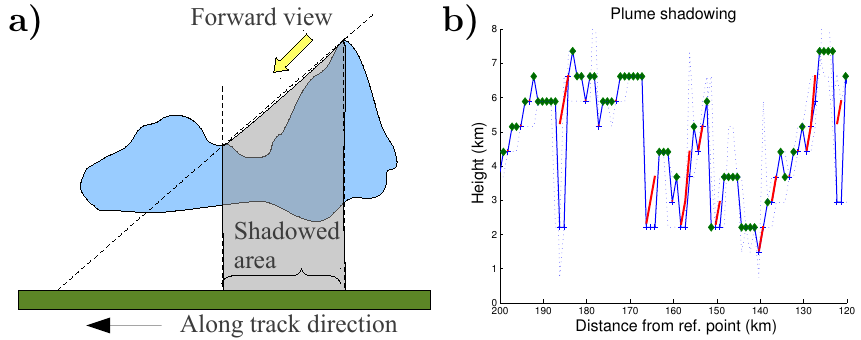
Figure 9. (a) Principle of the plume shadowing. A high feature can block the forward view (for lower features) in the along-track direction. A reliable height estimate cannot be obtained for pixels in the shadowed area. (b) An example of shadow masking, an along-track height profile. The blue line shows the initial height estimate. The high features block the forward view on the areas indicated by the red lines, preventing the height estimate. The green dots indicate heights accepted after the shadow masking. Note that in the shadowed areas the method typically suggests uniform, underestimated